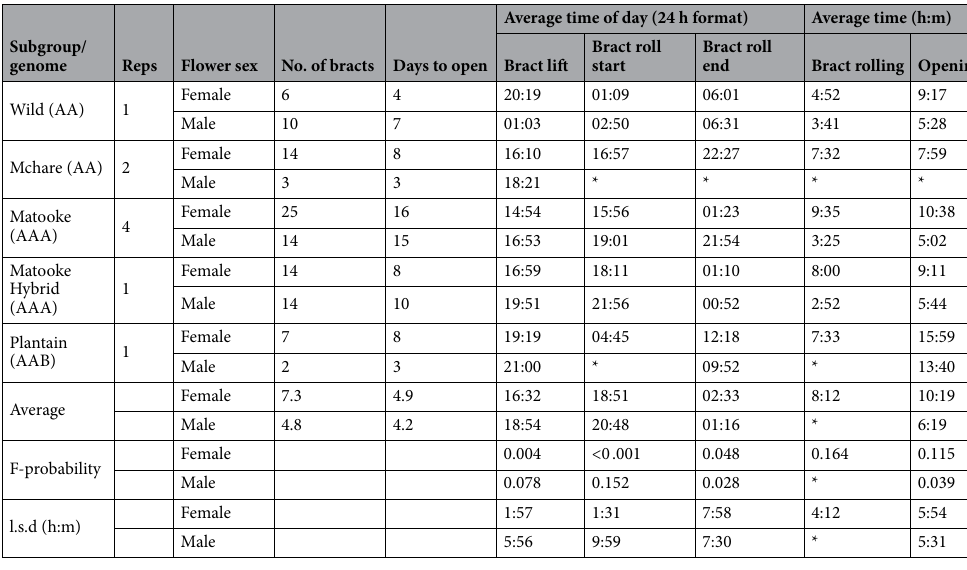
Table 1. Time of day and duration of bract opening events in selected banana genotypes. *Missing data, l.s.d—least significance difference, Reps—replicates which are number of cultivars within a subgroup, No. of bracts—number of bracts (total bracts observed for a given genotype/subgroup and sex of the flowers). Days to open are total number of days taken for observed bracts to open. Average time of bract events is in hours: minutes. Letters “A” and “B” in the parenthesis after genotype names are genome contributions from progenitors Musa acuminata and M. balbisiana